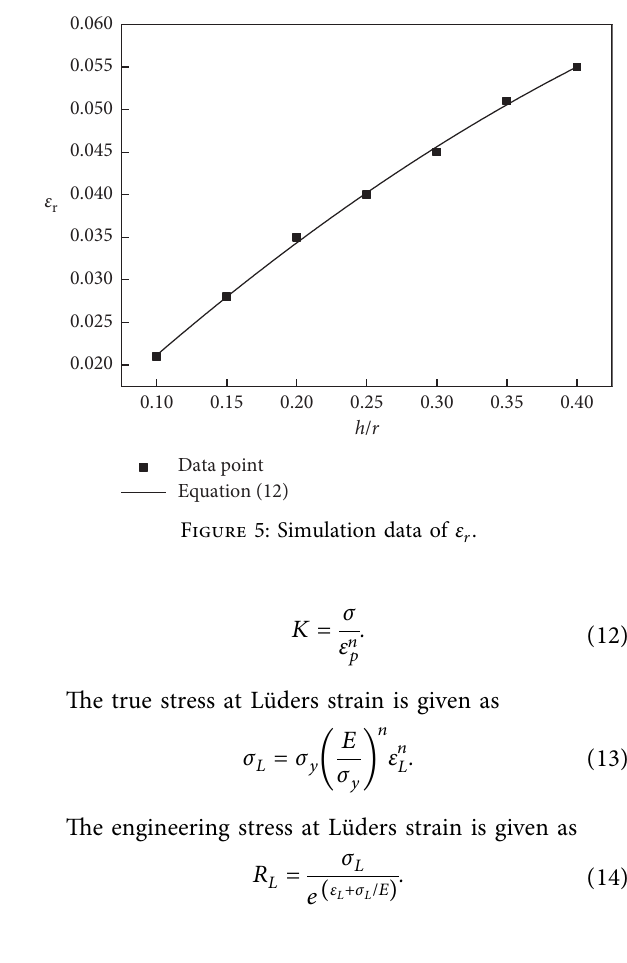
Figure 4: Relationship between W / ( h 3 σ